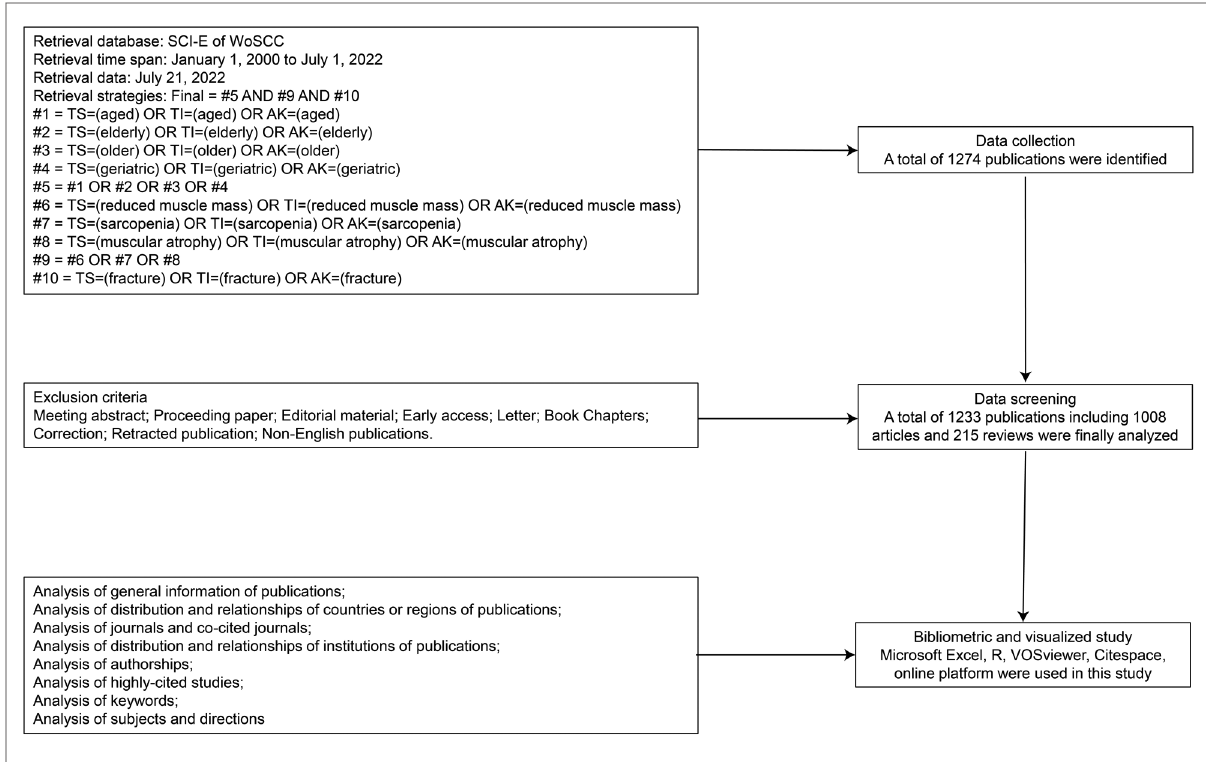
FIGURE 1 Flowchart of literature selection and analysis in this